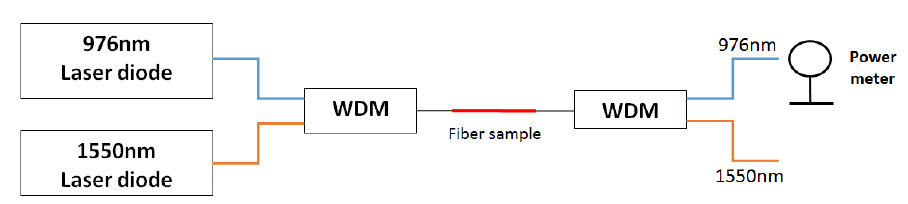
Figure 7. Photodarkening measurement setup.